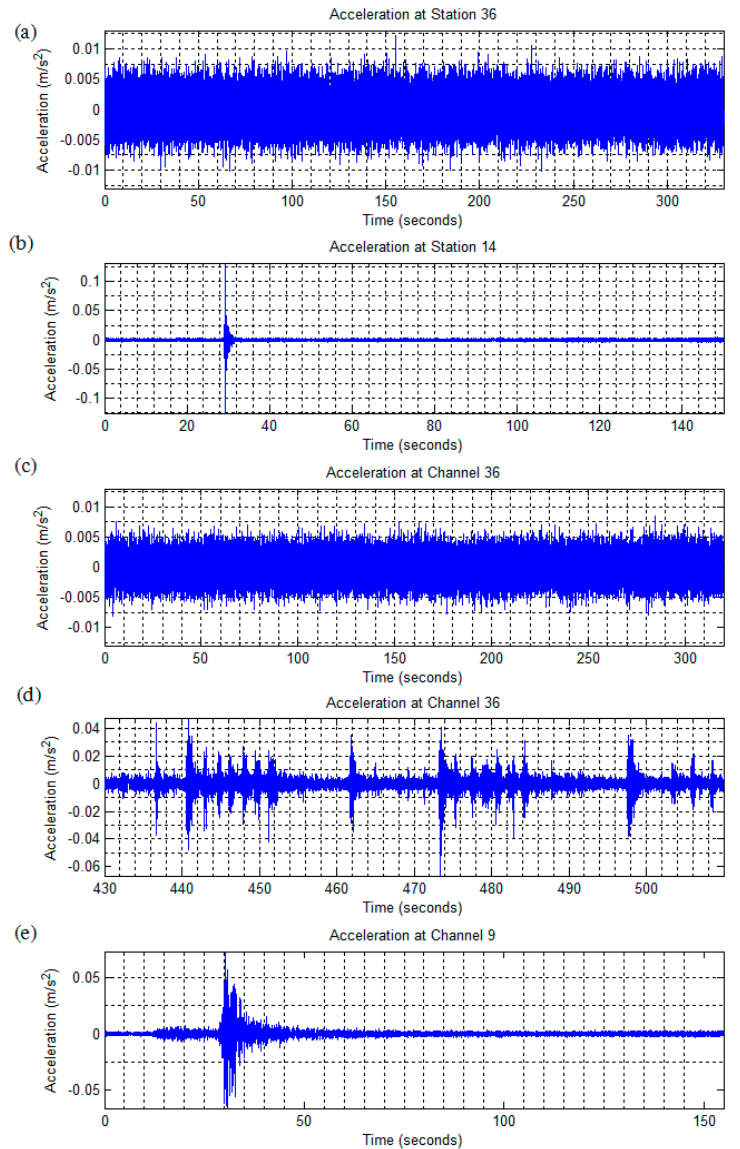
Figure 4. Sample time histories of recorded vibrations: ( a ) 4/7/2011 measurement: Acceleration time-history at the top floor (NS direction); ( b ) 5/14/2012 measurement: Acceleration time-history at the 2nd floor (NS direction); ( c ) 6/22/2012 measurement: Acceleration time-history at the top floor (NS direction); ( d ) 7/4/2012 measurement: Acceleration time-history at the top floor (NS direction) 10/16/2012 measurement: Response at the ground-level in the NS direction.